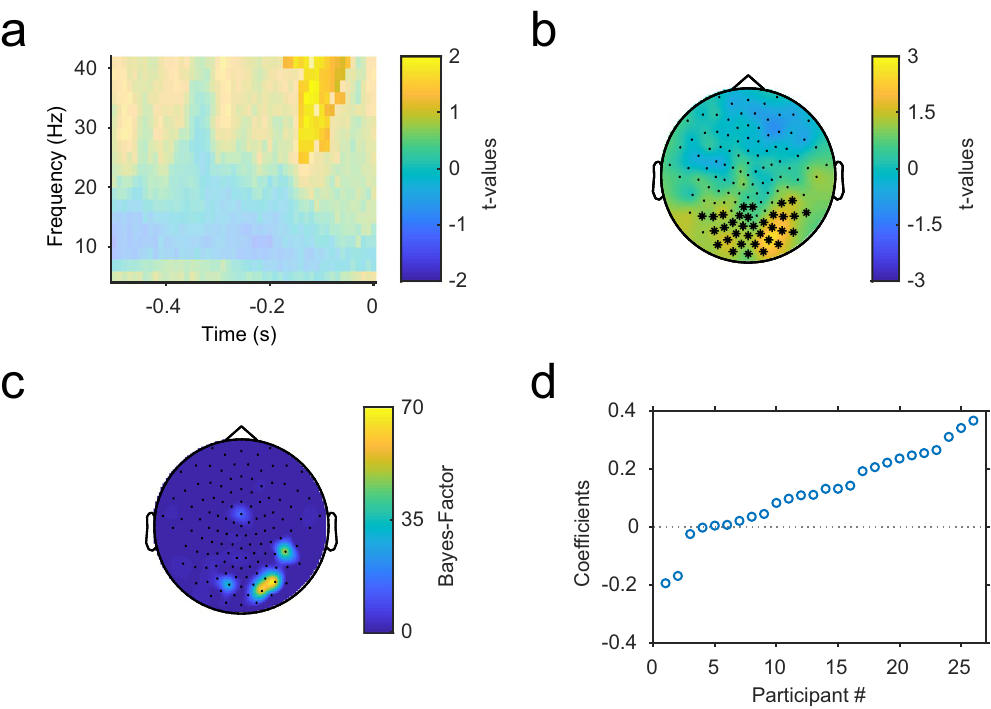
Figure 2. ( a ) Time frequency spectrum of t-values for the comparison of observed regression weights against dummy data, averaged over the significant channels. Significant regions are indicated by saturation. ( b ) Topography of t-values, averaged over the significant time-frequency region. Significant channels are marked by asterisks. ( c ) Topography of Bayes-Factor values, averaged over the significant time-frequency region. ( d ) Individual regression coefficients, averaged over the significant cluster. Participants are sorted in ascending order of the